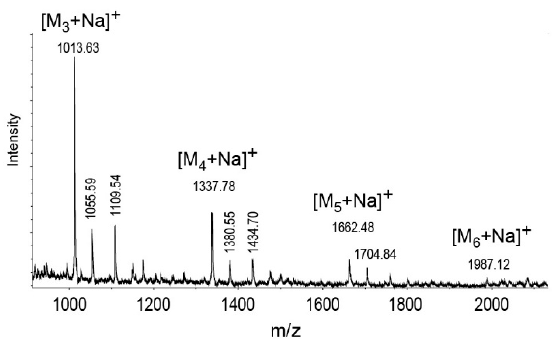
Figure 2. Matrix-assisted laser desorption ionization time-of-flight (MALDI-TOF) mass spectrum of the partially hydrolyzed polysaccharide fraction of Plesiomonas shigelloides 78/89 LPS. The MALDI-TOF mass spectrum was obtained in a positive linear mode. 2,5-Dihydroxybenzoic was used as matrix. M 3 , M 4 , M 5 , and M 6 represent the mass of the respective number of repeating units.